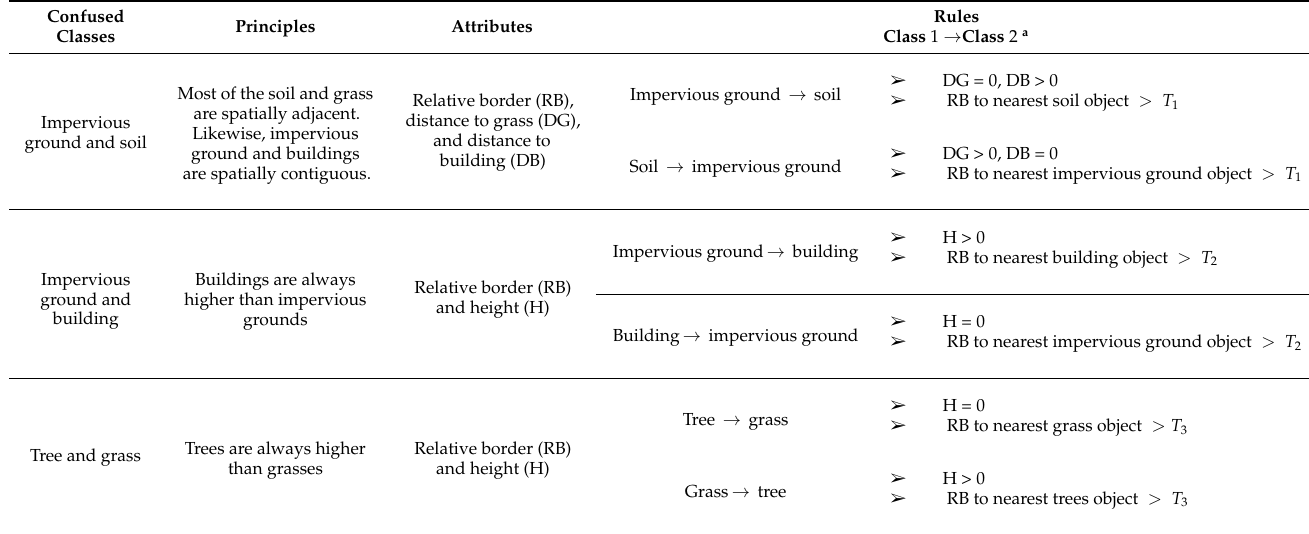
Table 3. Rules for the classification